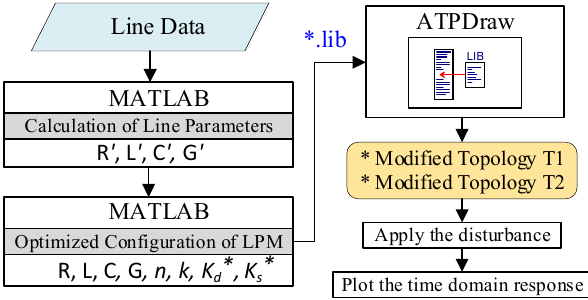
Figure 6. Flow-chart to compute the transient responses with the modified topologies using ATPDraw